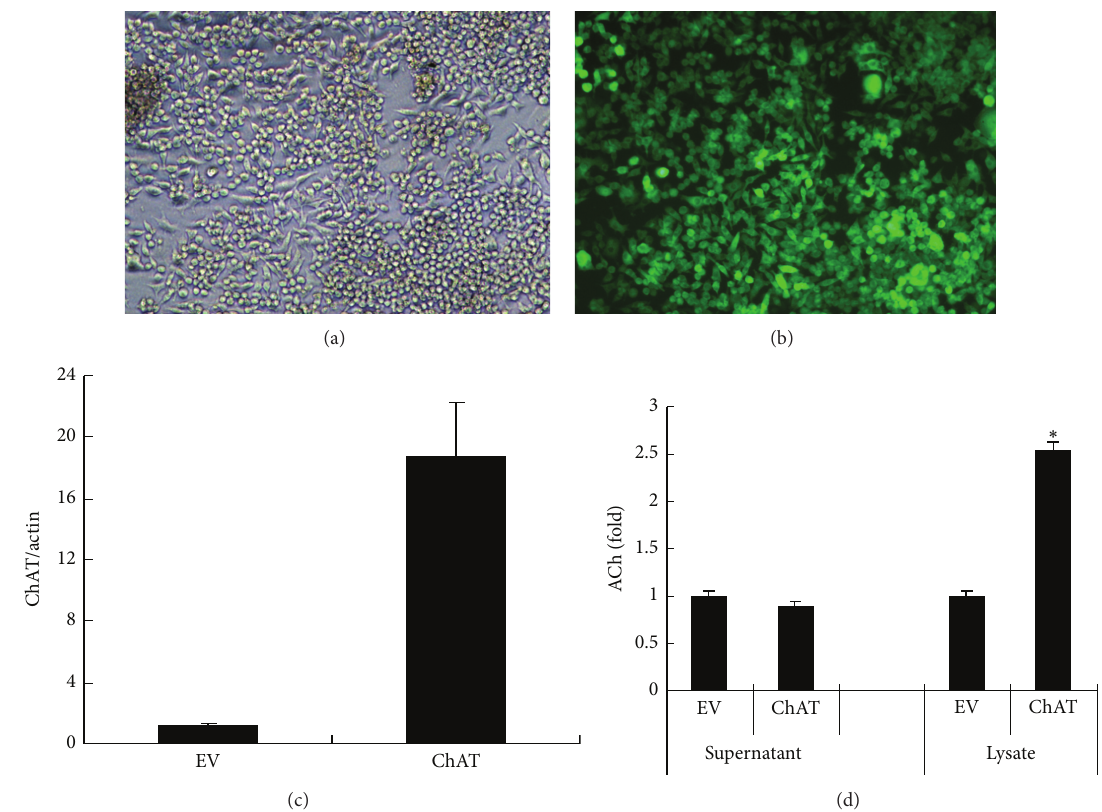
Figure 4: ChAT mRNA expression level and ACh secretion level in RAW264.7 cells transfected with empty vector (EV) or ChAT expression vector (ChAT). (a) RAW264.7 cells transfected by ChAT expression vector under inverted phase contrast microscopy ( × 100), which showed a good state. (b) GFP expression was more than 80% RAW264.7 cells infected by ChAT expression vector, under fluorescence microscopy ( × 100). (c) ChAT mRNA expression level was upregulated largely in RAW264.7 cells transfected by ChAT expression vector. (d) The amount of ACh in the supernatant and lysate of ChAT overexpressed RAW264.7 cells; the determination of ACh was performed by ELISA. Data are representative of three independent experiments and expressed as mean ± SD ( 𝑛 = 3 ), ∗ 𝑃 < 0.05 when compared with EV